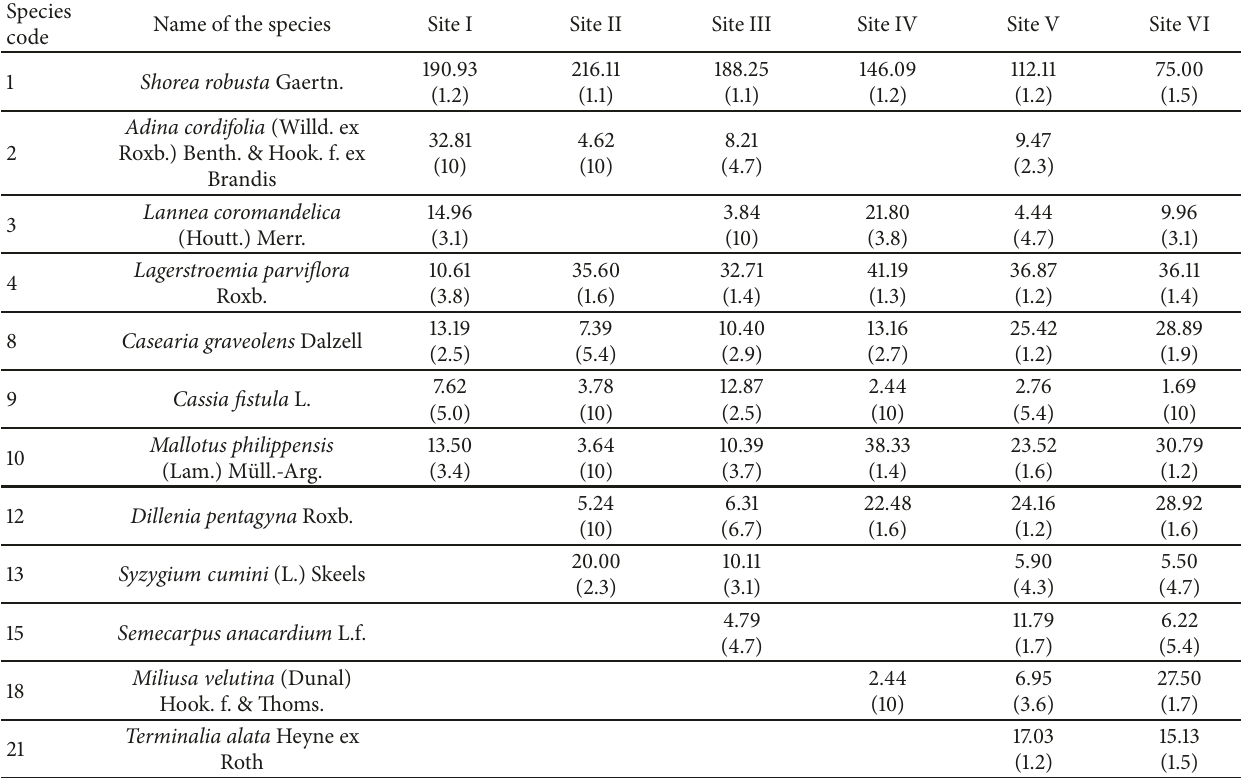
Table 11: IVI of predominant species and Morisita Index of Dispersion in Janajagaran BZCF. Species